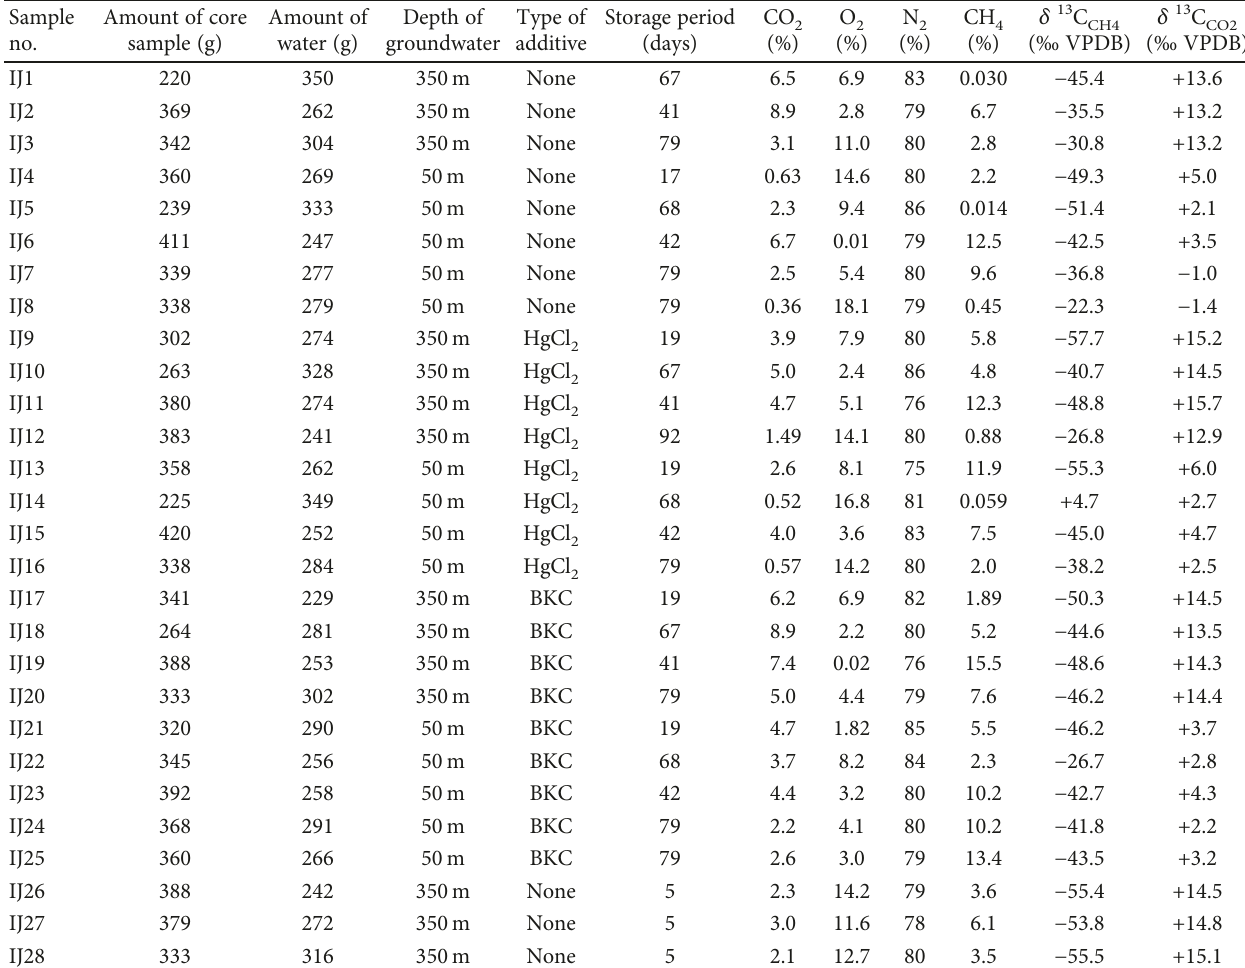
Table 1: Information on IsoJar ™ samples and analytical results of headspace